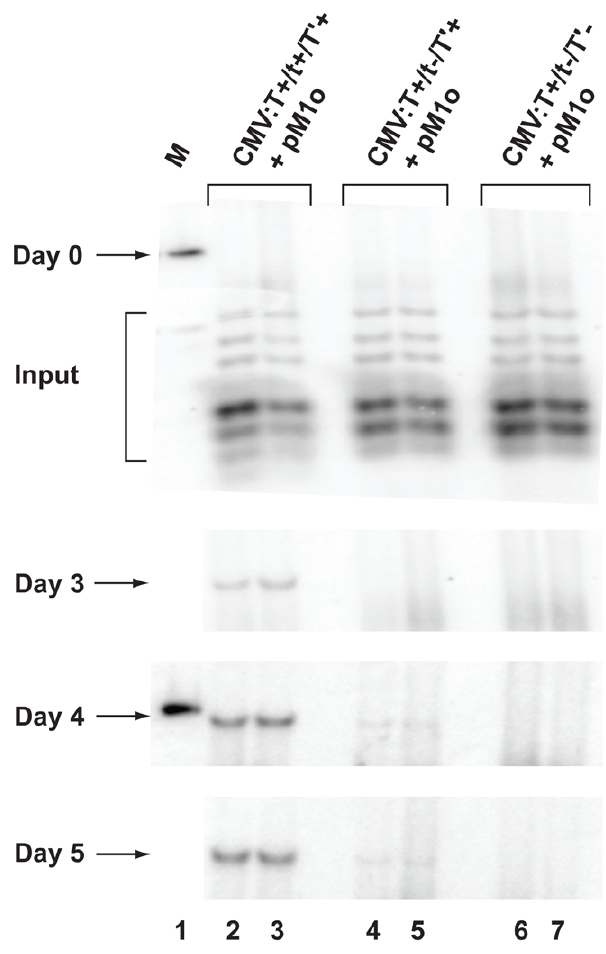
Figure 8. JCV early genes expressed from a CMV promoter induce replication of a JCV origin plasmid. PHFG cells in 60 mm plates were co-transfected in duplicate with 400 ng of the JCV replication origin plasmid, pM1o, and 400 ng of one of the following expression vectors that encode JCV early genes under the control of the CMV promoter: pCMV:T + /t + /T 9 + (lanes 2, 3; all five tumor proteins expressed), pCMV:T + /t 2 /T 9 + (lanes 4, 5; TAg and 3 T 9 proteins expressed) or pCMV:T + /t 2 /T 9 2 (lanes 6, 7; TAg only expressed). The ability of the proteins produced by the second plasmid to drive replication of the origin plasmid in trans was tested. Duplicate, independent samples representing each DNA construct were extracted by the method of Hirt [39] on days 0, 3, 4 and 5 p.t. and analyzed using the Dpn1 assay as described in the legend to Figure 5. The marker (M) shown in lane 1 of each blot is 1 ng of linear pM1o ( , 2400 bp), and the position of Dpn 1- resistent replicating genomes is denoted by an arrow at days 3–5 p.t. Dpn 1- and Eco RI-sensitive input DNAs are noted at the day 0 time point.